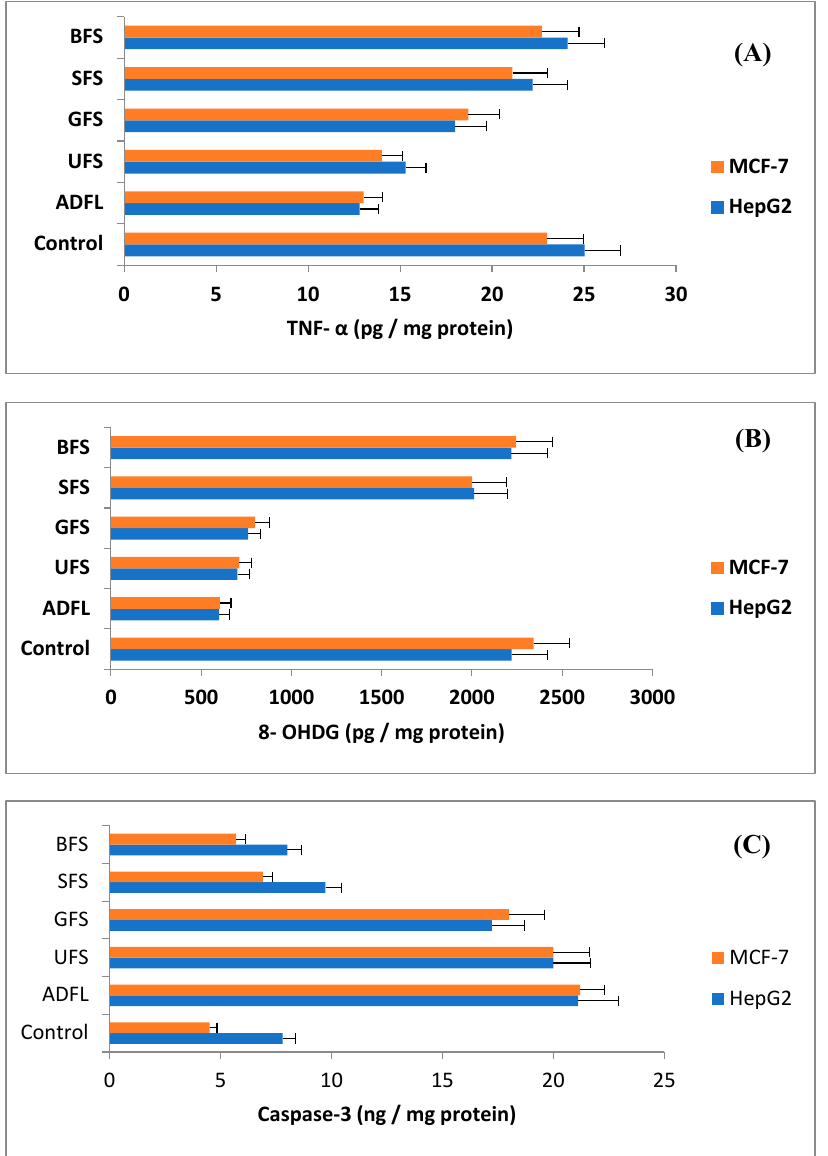
Figure 3. ( A ) (ELISA): The relative expression of tumor necrosis factor alpha (TNF- α ) of each untreated (Control) HepG2 and MCF-7 cancer cell lines and others treated with the IC 50 doses of air-dried fenugreek leaves (ADFL), untreated fenugreek seeds (UFS), germinated fenugreek seeds (GFS), soaked fenugreek seeds (SFS), and boiled fenugreek seeds (BFS). ( B ) The relative expression of 8-hydroxy-2- deoxyguanosine in untreated HepG2 and MCF-7 cancer cell lines and those treated with the IC 50 doses of ADFL, UFS, GFS, SFS, and BFS. ( C ) The relative expression of Cas-3 in untreated HepG2 and MCF-7 cancer cell lines and those treated with the IC 50 doses of ADFL, UFS, GFS, SFS, and BFS. An 8-Hydroxy-2 ′ -deoxyguanosine (8-OHDG) biomarker was evaluated to measure DNA damage. The results presented in Figure 3B are significant for all tested samples, especially the air-dried fenugreek leaves (ADFL), which had the most potent activity for reducing the 8-OHDG factor compared to the untreated cell line (control). The level of 8- OHDG factor in the hepatic (HepG2) and breast (MCF-7) cell lines appeared to be 600 and